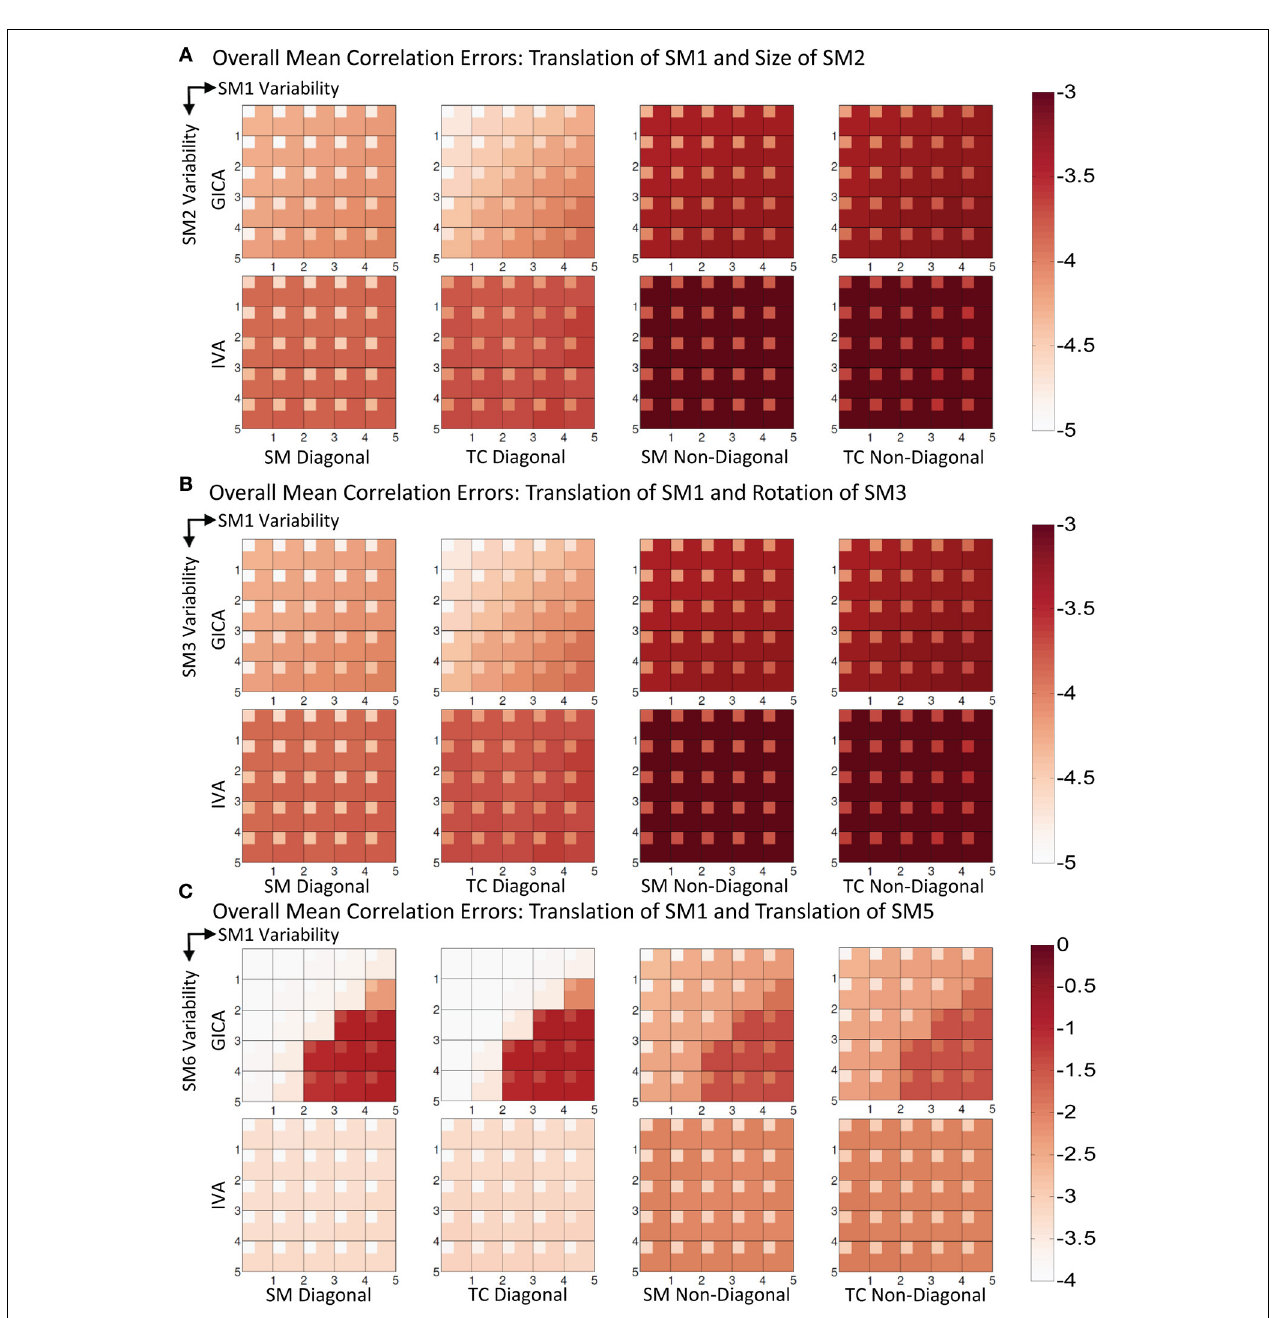
FIGURE 6 | Results of Experiment 3: Estimation when two components are varied across subjects. Overall mean correlation errors (across all subjects and components) are presented as images for diagonal and non-diagonal elements of for SM and TC separately. Increase in variability is from left to right of the image and from top to bottom. For details on the degree of variability at each step refer to the “Simulation Experiment Setup, Experiment 3” section. The errors are in log10 scale as indicated by the colorbar. (A) Translation of SM1 and size change of SM2. Both GICA and IVA